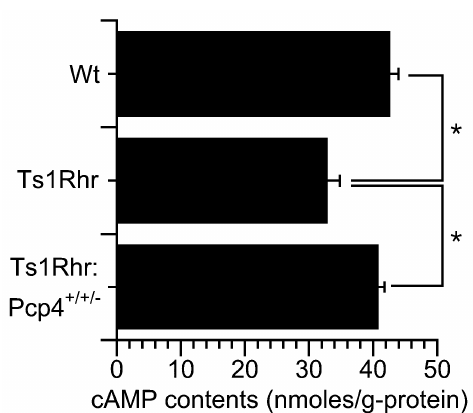
Figure 6. Cyclic AMP (Adenosine monophosphate) contents in isolated lung cells from Wt, Ts1Rhr, and Ts1Rhr: Pcp4 +/+/- . Under unstimulated conditions, the cAMP content of lung cells from Ts1Rhr was lower than that of lung cells from Wt or Ts1Rhr: Pcp4 +/+/- . * significantly different ( p < 0.05)